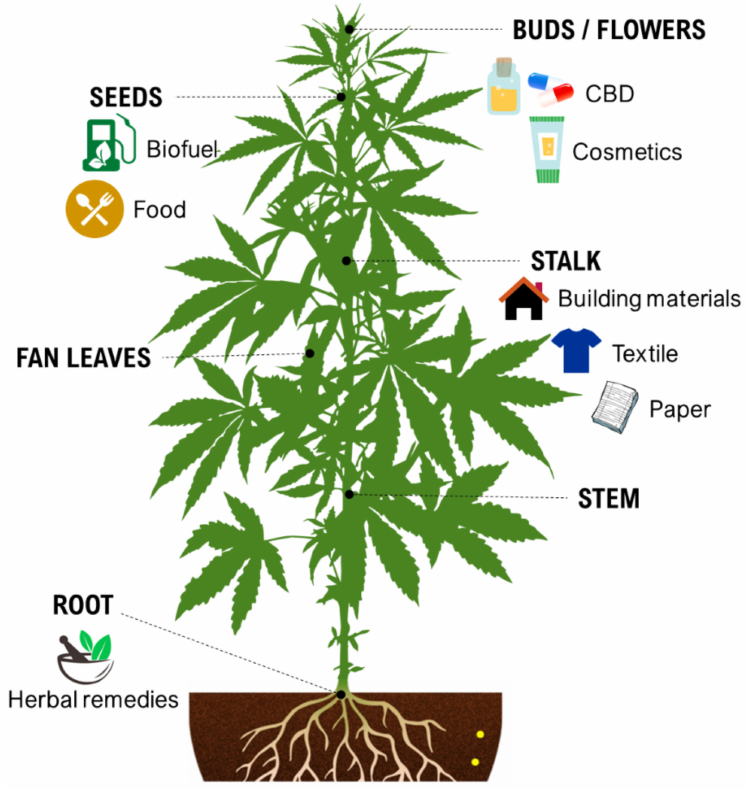
Figure 1. Some industrial properties of Cannabis.